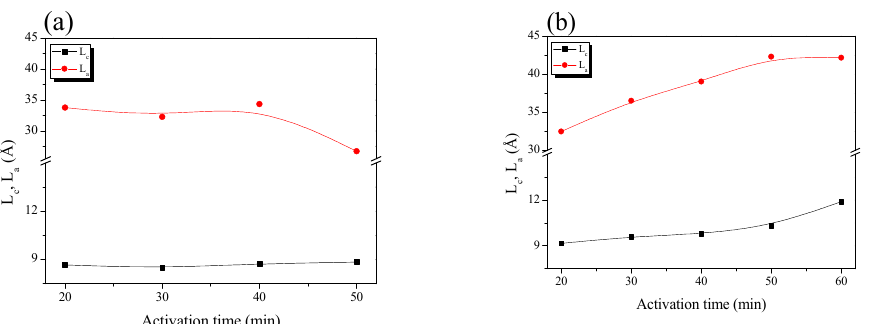
Figure 4. Structural characteristics of the bamboo-derived activated carbon as a function of steam activation conditions: ( a ) CB-AC and ( b ) PB-AC.